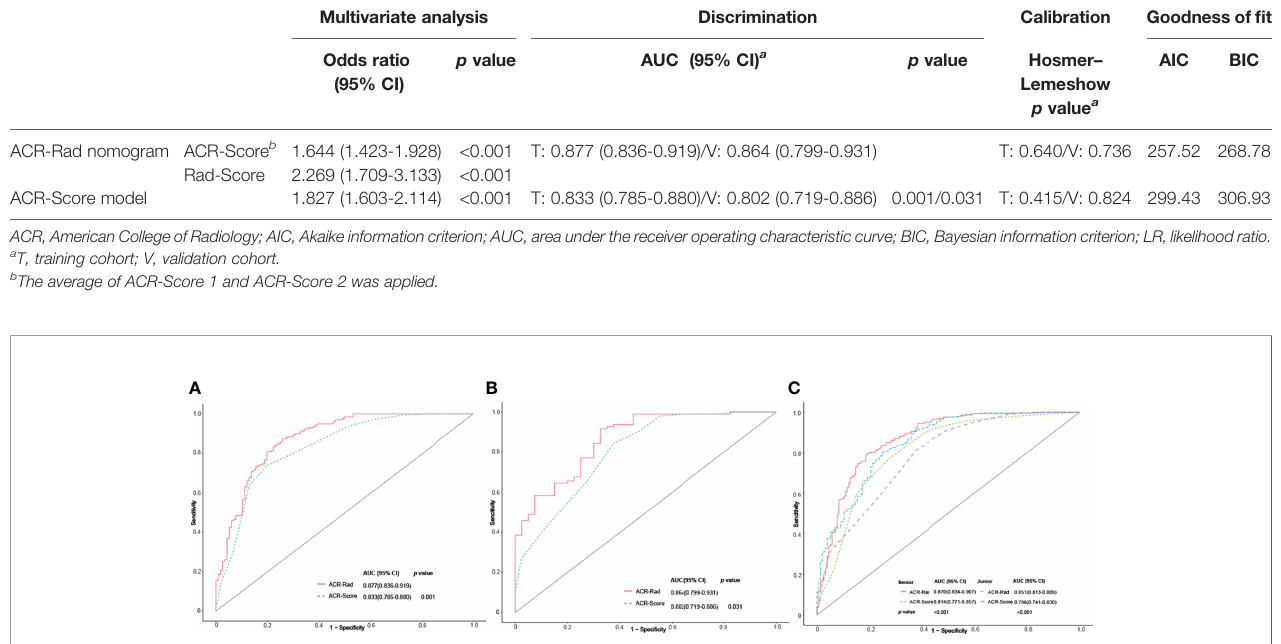
FIGURE 4 | Receiver operating characteristic (ROC) curves of the ACR-Rad nomogram and ACR-Score model in the training (A) , validation (B) , and entire (C) cohorts.